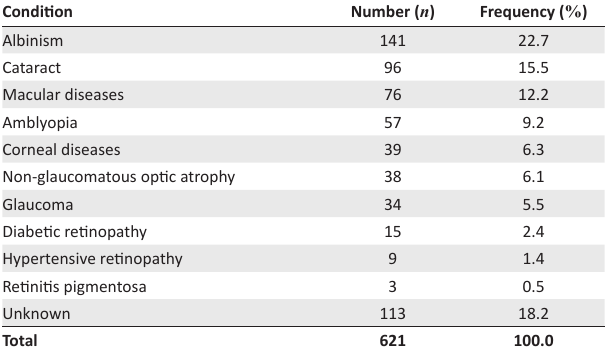
TABLE 3: Causes of low vision in 621 patients attending the low vision clinic, Department of Optometry, University of KwaZulu-Natal, from January 2010 to